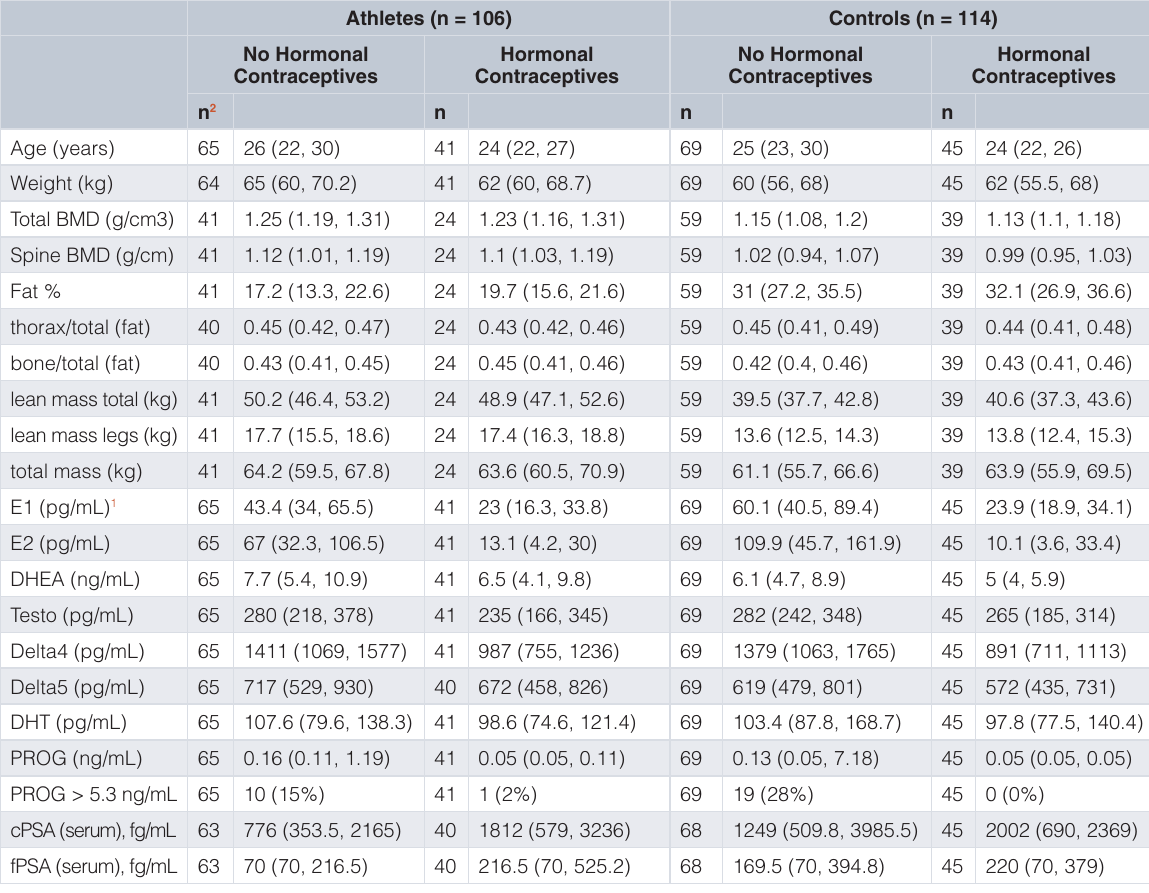
Table 1. Median (25th, 75th percentiles) anthropometric measurements of athletes and controls, stratified by hormonal contraceptive use.